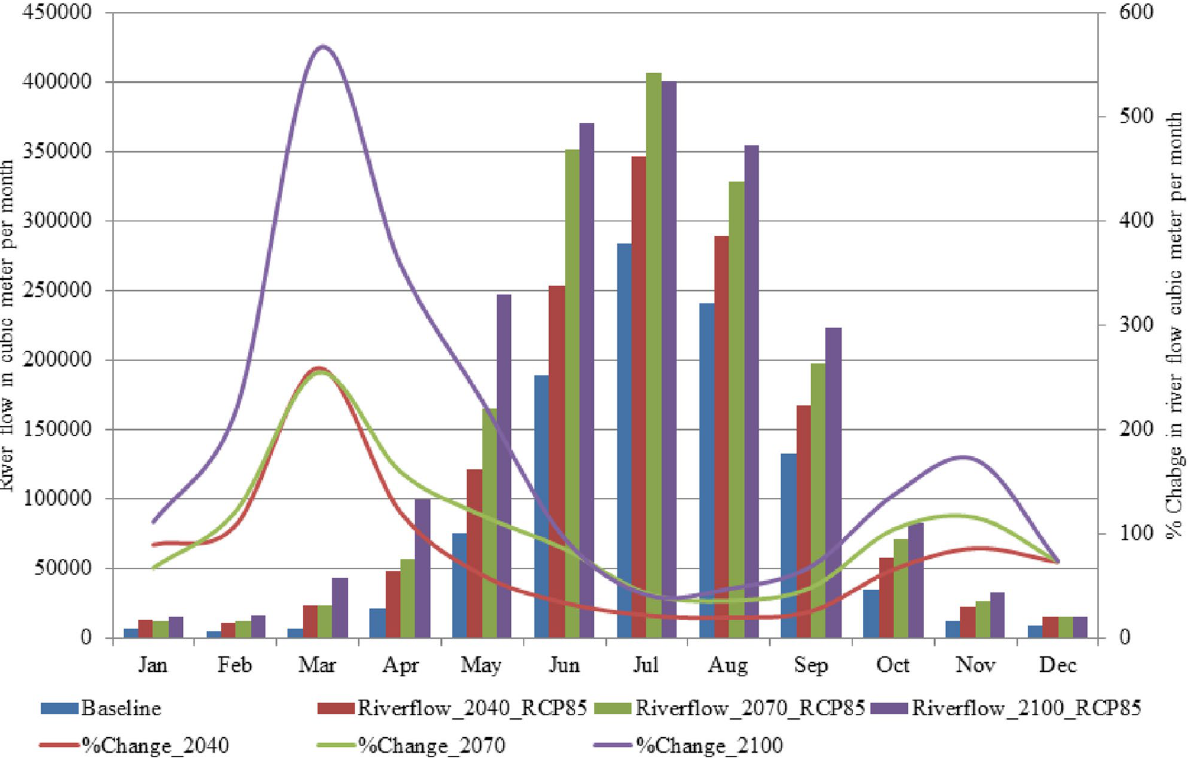
Figure 5. Similar to Fig. 4 but using the RCP8.5 scenario.